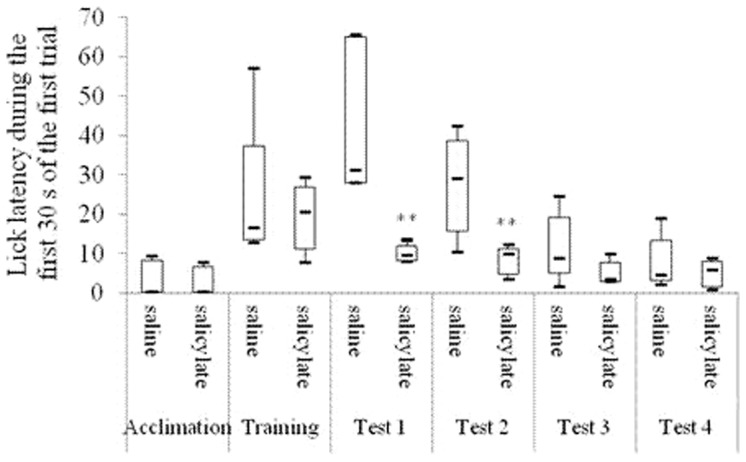
Lick latency (i.e. the start time of licking water) during the first 30 s of the first trials in different behavioral periods. “Acclimation” shows the average of the lick latency of all rats in the saline or the salicylate group in the 2-day acclimation period; “Training” shows the average of the lick latency of all rats in the saline or the salicylate group in the 7-day training period;. Tests 1–4 show the 1st, 2nd, 3rd, and 4th day in the test period, respectively. **P<0.01 is compared with the saline group.